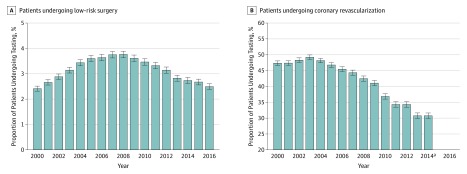
Annual Rates of Low-Value TestingAll testing rates are adjusted for age and sex. Error bars show 95% CIs.aAnnual rates end in 2014 to allow for 2-year look-forward period.